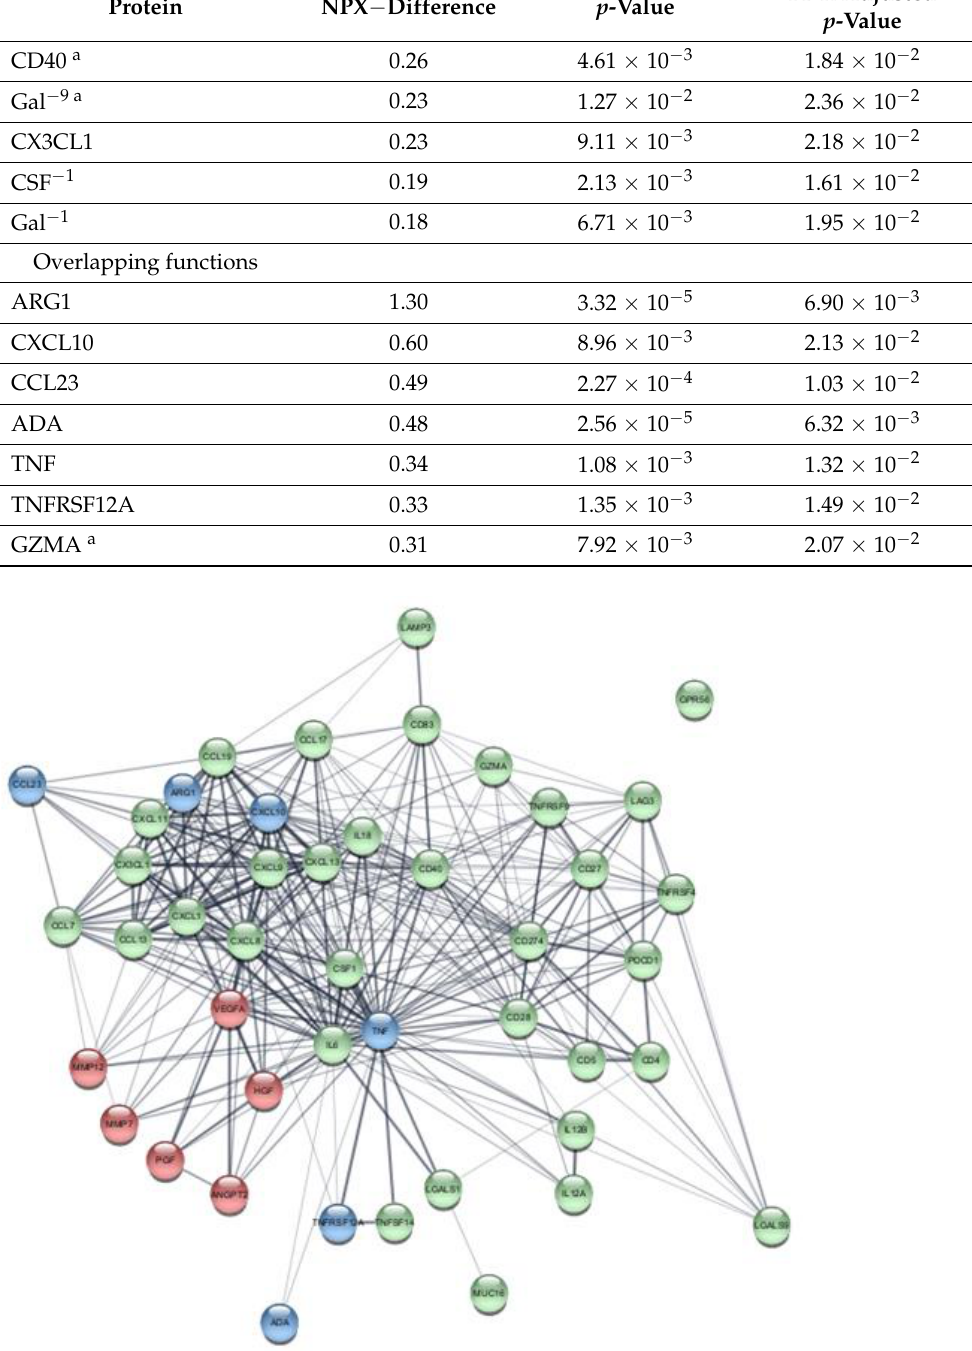
Figure 3. Bioinformatic analysis of elevated proteins in IPF serum. Network of protein-protein interaction of significantly elevated proteins in IPF serum at baseline compared to healthy controls Annotated biological functions are highlighted with color-coded nodes. Nodes categorized according to biological function; Red nodes= tissue remodeling, Green nodes = inflammation/chemotaxis, Blue nodes= overlapping functions.